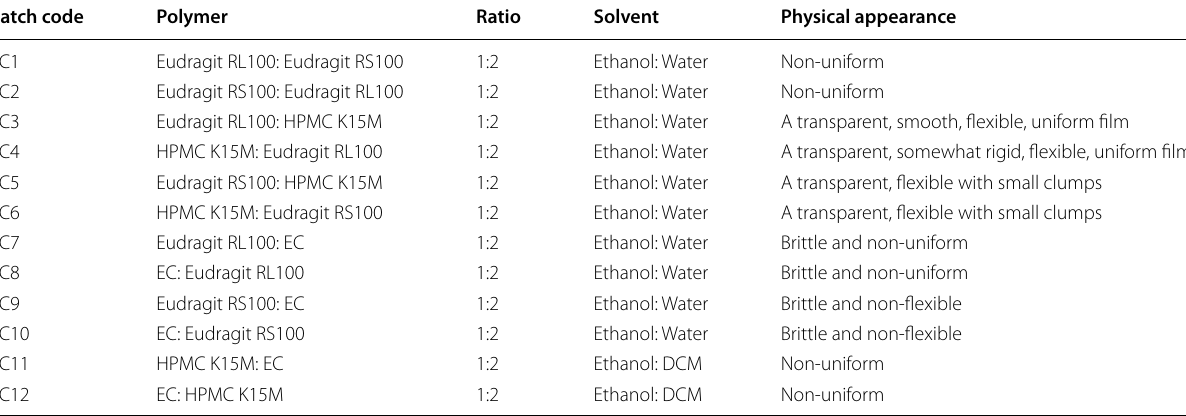
Table 1 Composition of several placebo polymeric patches for polymer selection Batch code